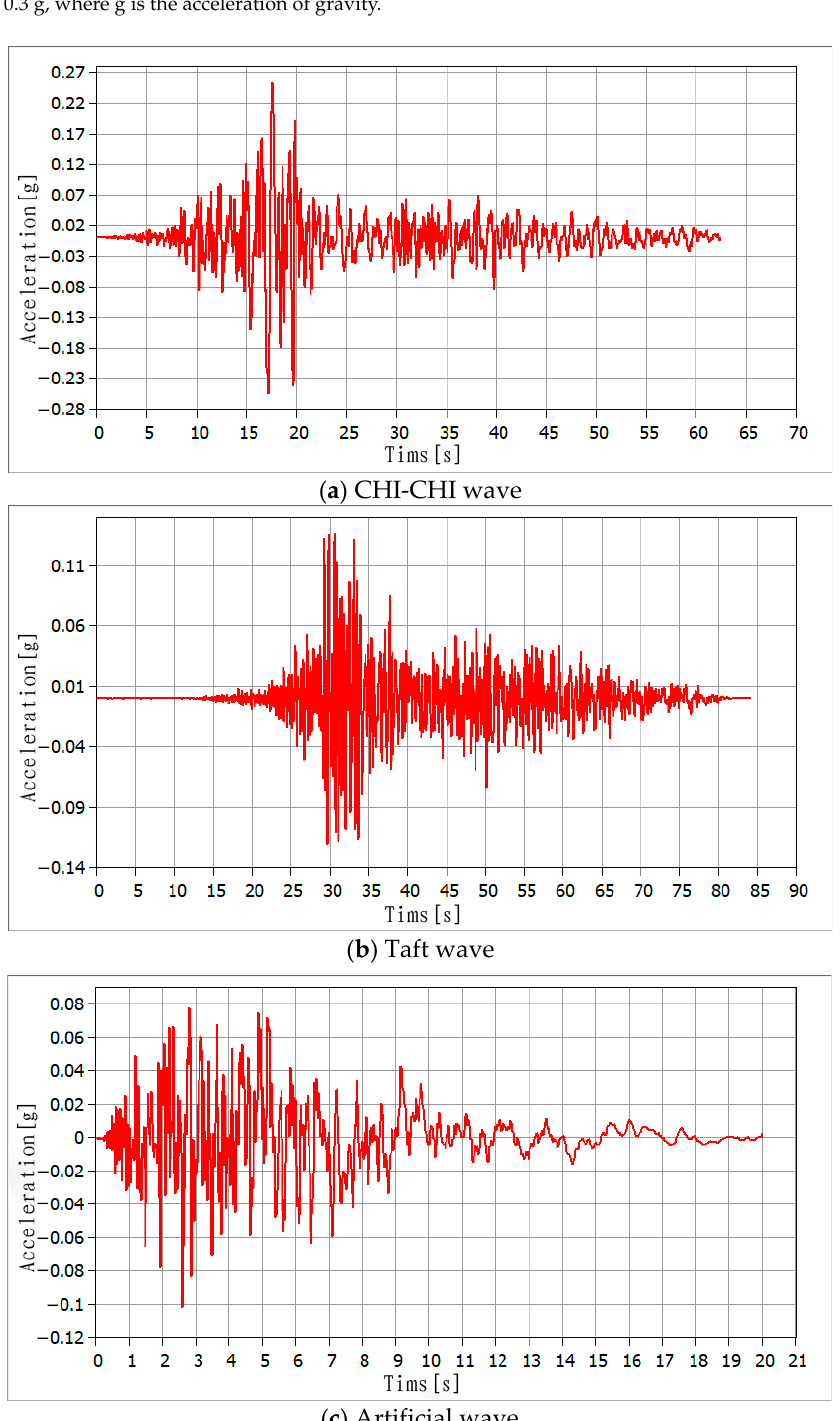
Figure 4. Time-history curve of the seismic waves.